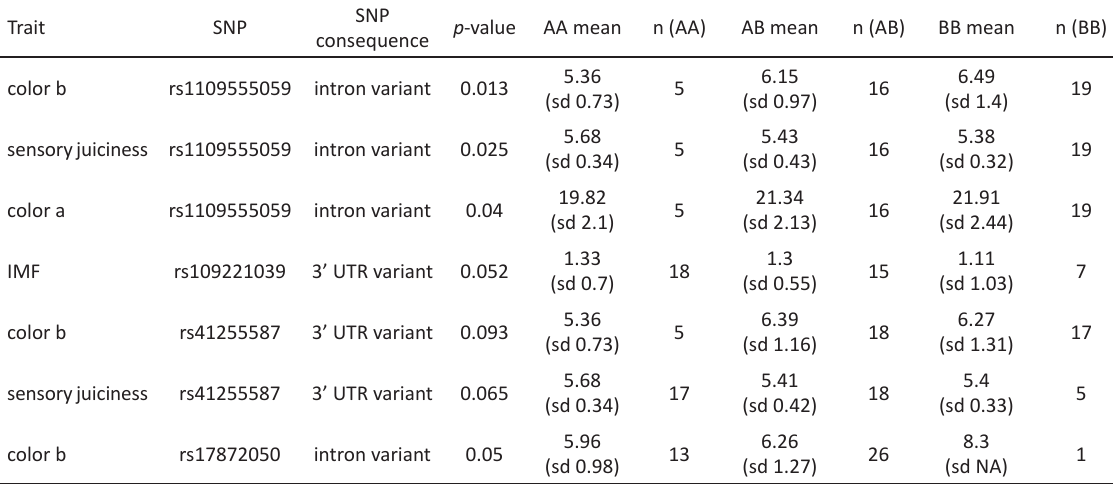
SNP consequence SNP p -value consequence